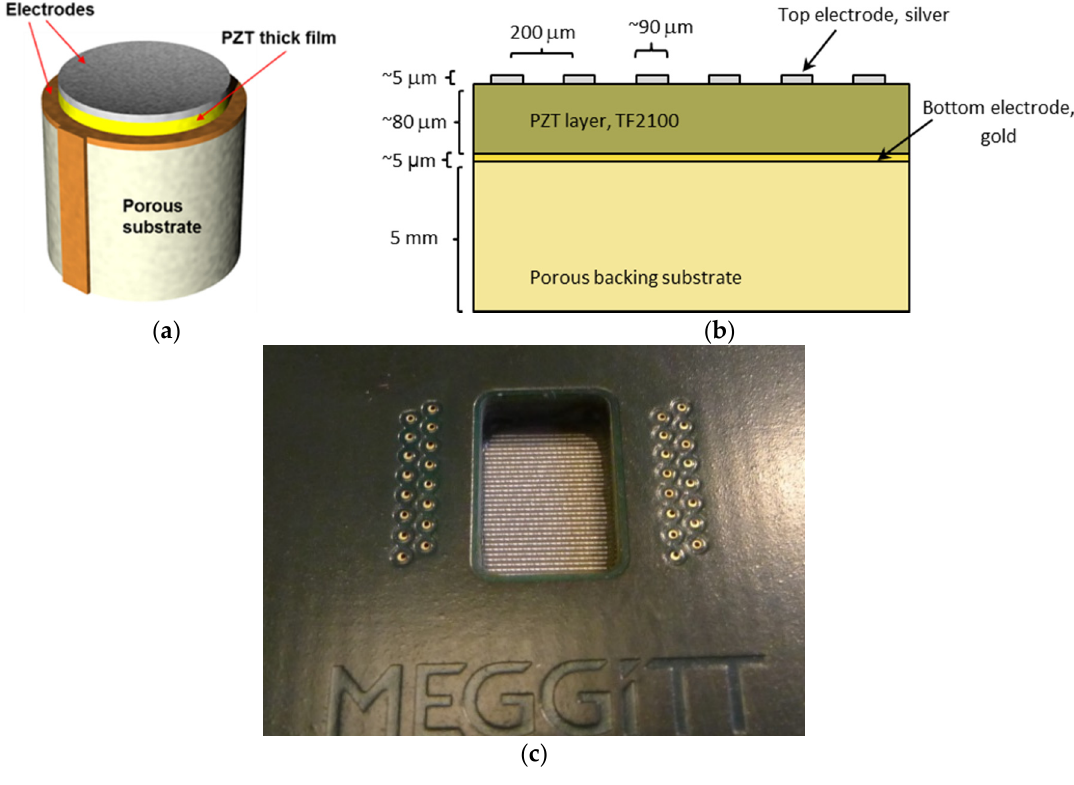
Figure 8. ( a ) Typical structure of a commercial high ‐ frequency single ‐ element transducer based on pad ‐ printed piezoceramic thick film. The thickness of the piezoceramic film is approximately 20 μ m; ( b ) Schematic drawing of structure of the linear array with a pitch of 200 μ m, based on piezoceramic thick film; ( c ) Photo of the 32 ‐ element screen ‐ printed linear array mounted on a printed circuit board. The overlapping length of the line elements is 5 mm. ( b ) and ( c ) © 2015 IEEE. Reprinted, with permission, from DOI 10.1109/ULTSYM.2015.0277.